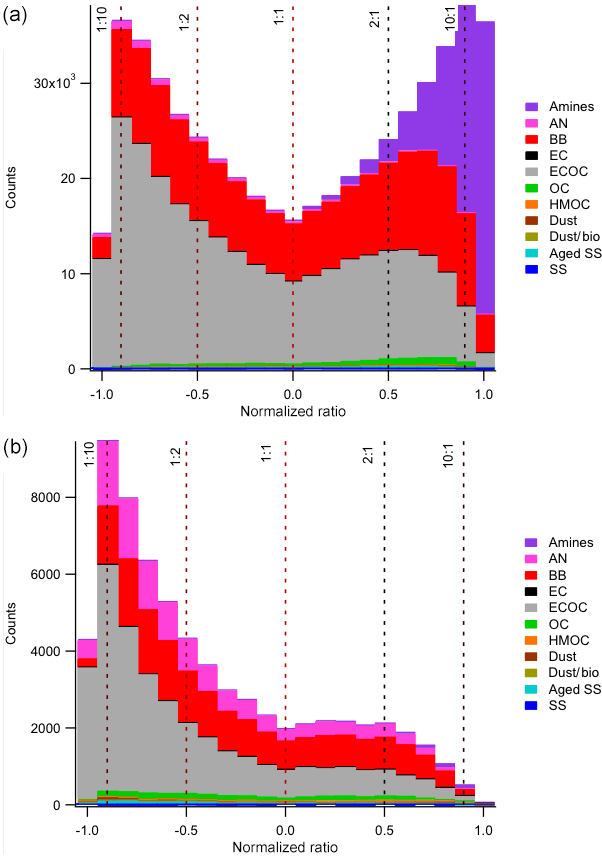
Figure 8. As in Fig. 7 except that amines:ammonium ion ratio dis- tributions are shown. Figure 9. As in Fig. 7 except that OC:soot ion ratio distributions